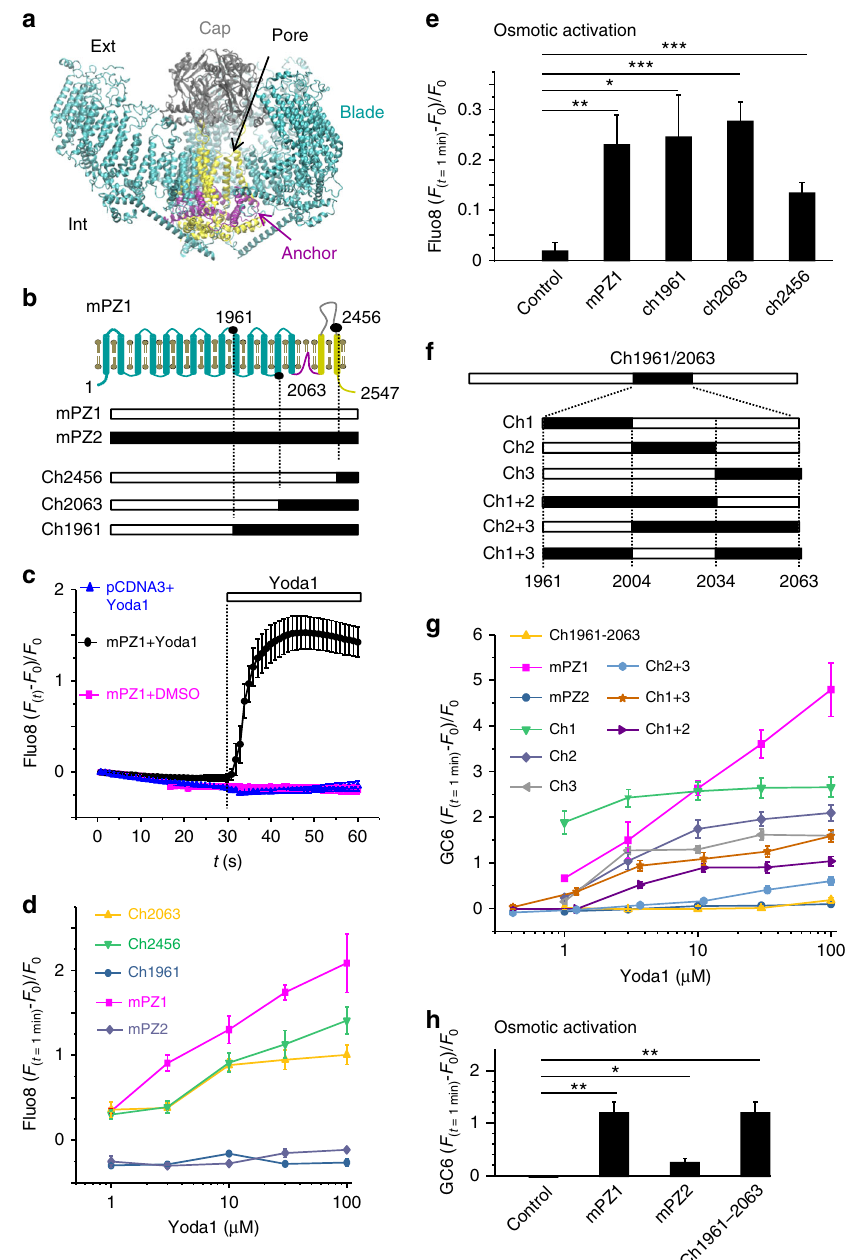
Fig. 1 Design of a Yoda1-insensitive Piezo1 chimera. a mPZ1 cryo-EM structure (PDBID:6B3R) created using Molecular Visual Dynamics (VMD) with structural features highlighted with differential coloring. b Generation of C-terminal Piezo chimeras with respect to their approximate position with a simplistic mPZ1 topology (coloring identical to a , residues position not to scale). Residue numbers are from mPZ1. c Relative Ca 2 + -sensitive fl uorescence time course in HEK 293T cells transfected with WT mPZ1 (black and magenta traces) or the empty vector pCDNA3 (blue trace). Cells were pre-loaded with Fluo8-AM and incubated with 30 µ M Yoda1 (blue and black traces) or a control solution (magenta trace) at t = 30 s. d Relative fl uorescence changes from HEK 293T cells expressing the indicated constructs plotted against Yoda1 concentration. e Relative fl uorescence changes from HEK 293T cells transfected with the indicated construct or with the empty vector pCDNA3 following an acute hypotonic shock. f Generation of internal Piezo chimeras. Residue numbers are from mPZ1. g Relative changes of Ca 2 + -sensitive fl uorescence measured using GCaMP6m (GC6) for the indicated Piezo channels and chimeric variants and plotted as a function of Yoda1 concentration. h Relative fl uorescence changes from HEK 293T cells expressing the indicated construct or the empty vector pCDNA3 following an acute hypotonic shock. In d and g , the experiment was done in duplicate and repeated four times. In